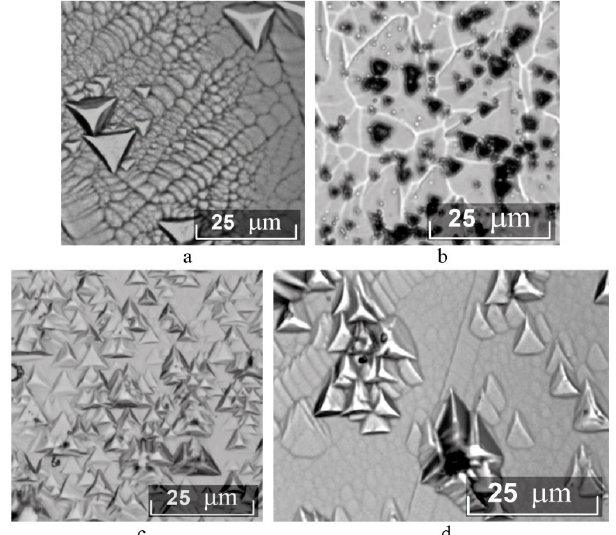
Figure A11. Defective micro-structure in heavily doped crystals: ( a )–A “network” of triangular microdomains in a LiNbO 3 :Zn crystal ([ZnO] = 6.5 mol% in the melt); ( b )–An accumulation of triangular microdomains against the background of a mosaic “grid” in a LiNbO 3 :Zn crystal ([ZnO] = 4.69 mol% melt); ( c )–An accumulation of triangular domains, a sign of inhomogeneity of the chemical composition, in the LiNbO 3 :Mg crystal ([MgO] ≈ 4.4 mol% in the crystal); ( d )–Poorly formed mosaic structure in a LiNbO 3 :Mg crystal (direct doping, [MgO] ≈ 4.77 mol% in the crystal), Z-cut, with shapeless structural formations, probably crystallization centers of the second phase.